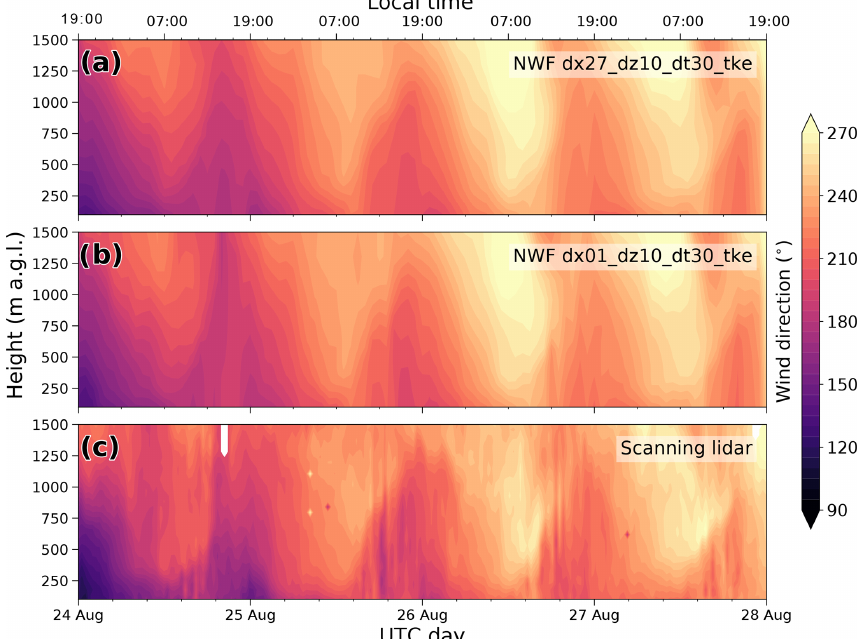
Figure 4. Time–height cross sections comparing wind direction from (a) the no wind farm (NWF) run of the dx27_dz10_dt30_tke simulation with (b) the NWF run of dx01_dz10_dt30_tke , and (c) the scanning lidar